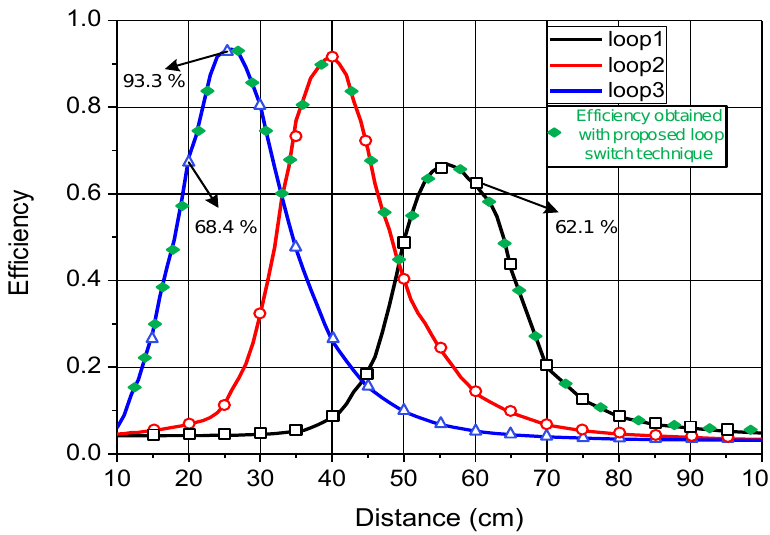
Figure 13. Measured efficiency using the RF power meter for different loops with varying d 23 in the Case 2 system.